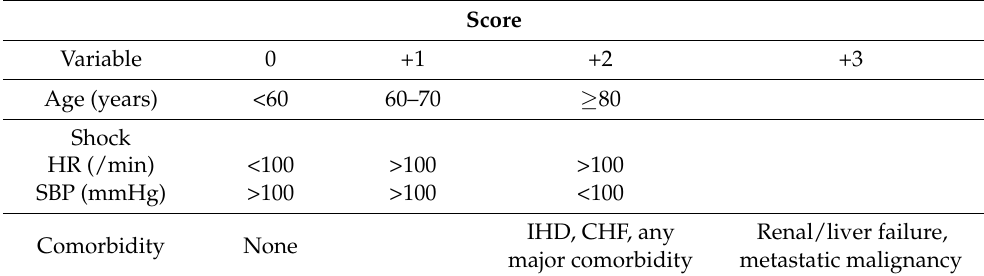
Table 1. Pre-endoscopy Rockall score [21].